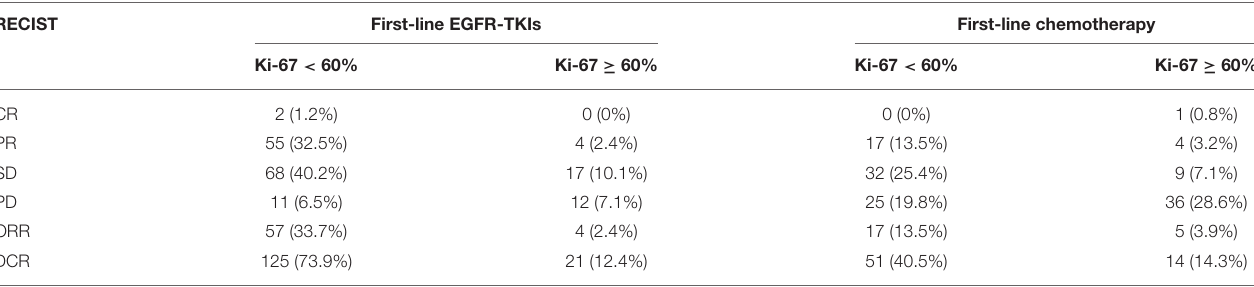
TABLE 4 | The short-term efficacy comparison among EGFR-TKIs and chemotherapy with Ki-67 in NSCLC.